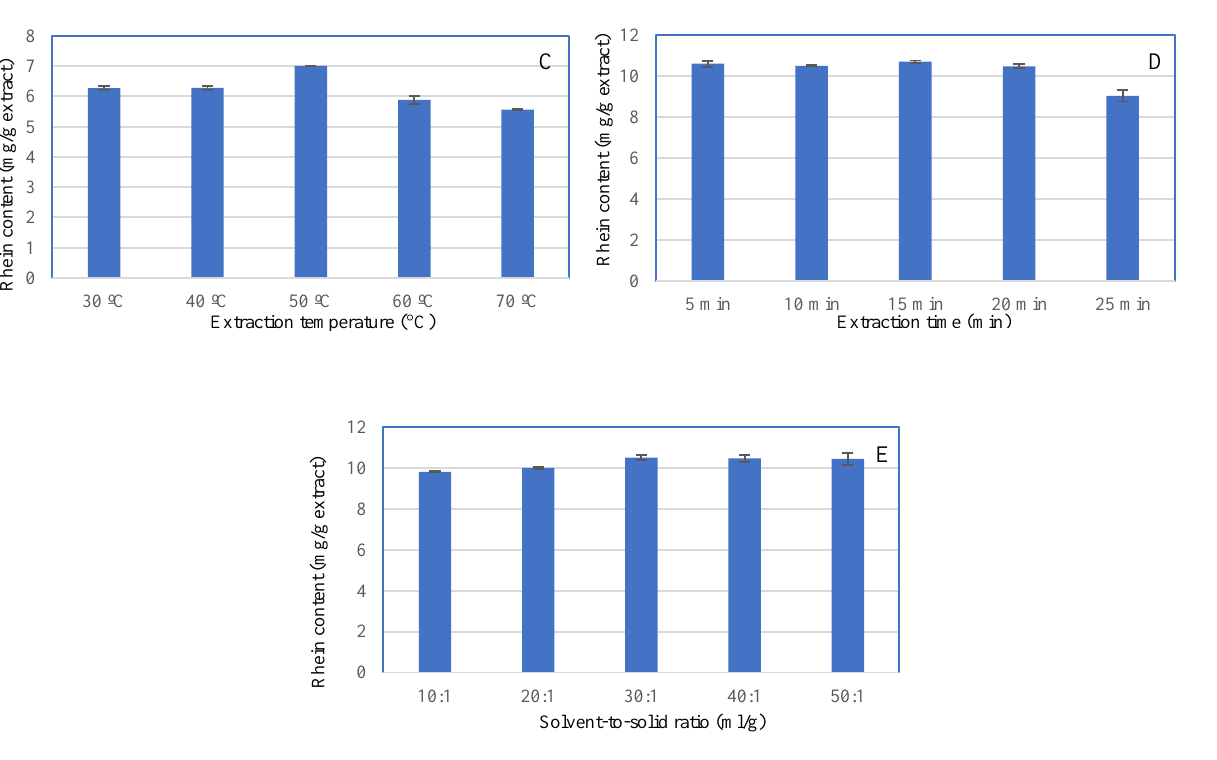
Figure 3. Effects of solvent type ( A ), solvent concentration ( B ), extraction temperature ( C ), extraction time ( D ) and solvent-to-solid ratio ( E ) on the rhein content of the